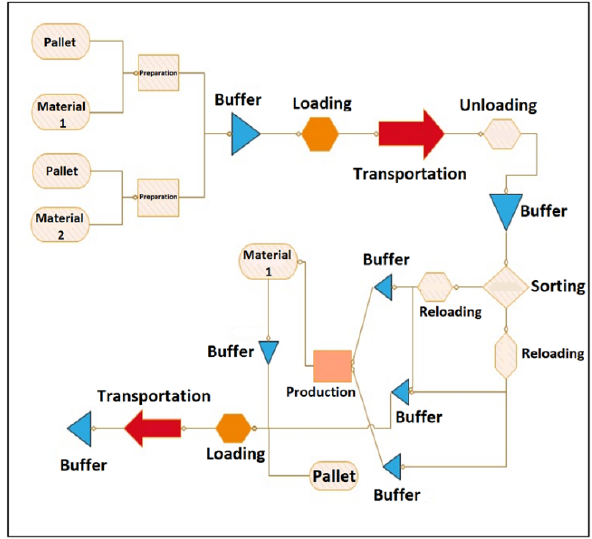
Figure 8: Diagram of the simulation model